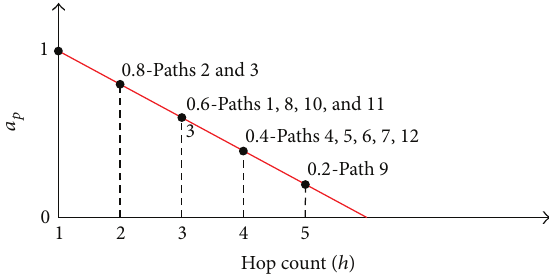
Figure 7: The values of ℎ 𝑝 of the paths in the simulation scenario.